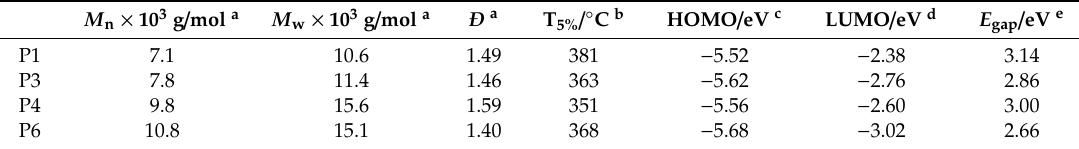
Figure 3. Size-exclusion chromatography (SEC) chromatograms of polymers. Table 1. Polymer Properties and